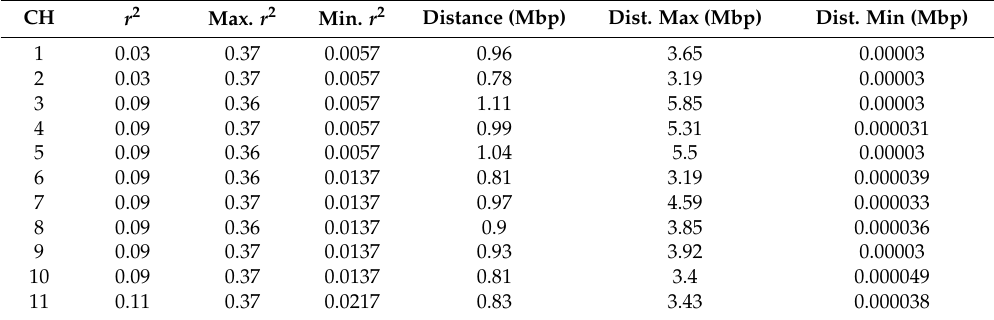
Figure 2. Genome-wide linkage disequilibrium (LD) decay pattern for the study population of Eucalyptus globulus . Labill. Pairwise LD values expressed by r 2 ; LD ( R 2 ), as adjusted according to Hill and Weir [53] (curve colored by black). Distance (bp) is the distance between SNP pairs. The LD threshold of r 2 = 0.1 is indicated with a dotted line. Table 3. LD estimates (corrected by the relatedness) for each chromosome. Distance (Mbp) and r 2 express the average values of genomic distance and LD between pairs of markers. Max. r 2 and Min. r 2 correspond to the maximum and minimum LD values, respectively, found between each pair of markers. Dist. Max and Dist. Min represent the maximum and minimum distance between markers found in LD, respectively. CH is the number of chromosome of Eucalyptus .